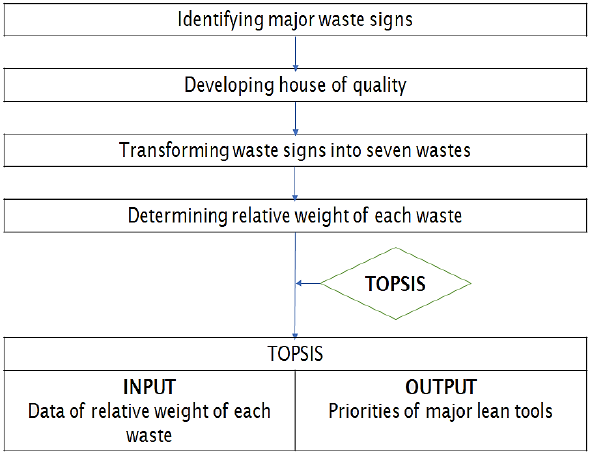
Figure 2. Integrated QFD-TOPSIS